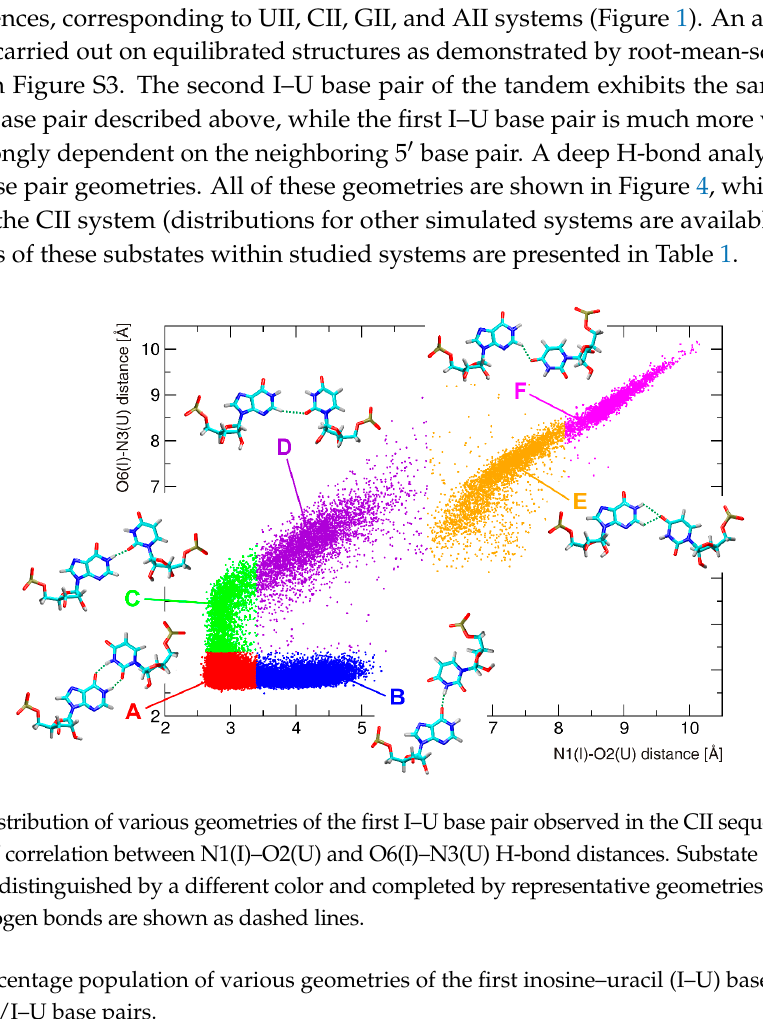
Table 1. Percentage population of various geometries of the first inosine–uracil (I–U) base pair in the tandem I–U/I–U base pairs.